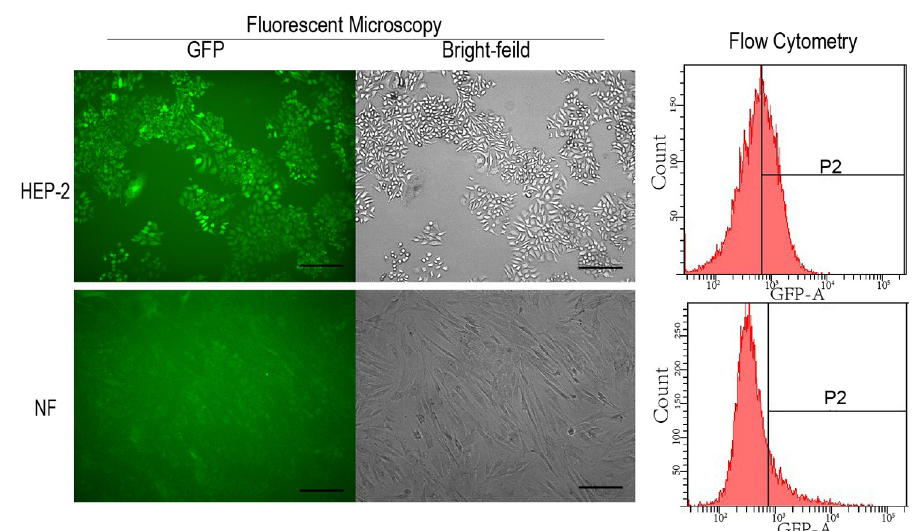
Fig 2. GFP expression in HEP-2 and NF cell lines after Ad- GFP infection. HEP-2 and NF cells were infected with Ad-GFP at a MOI of 50 for 72 h. GFP expression was visualized by fluorescent microscopy and quantified by flow cytometry. Bar = 200 μ